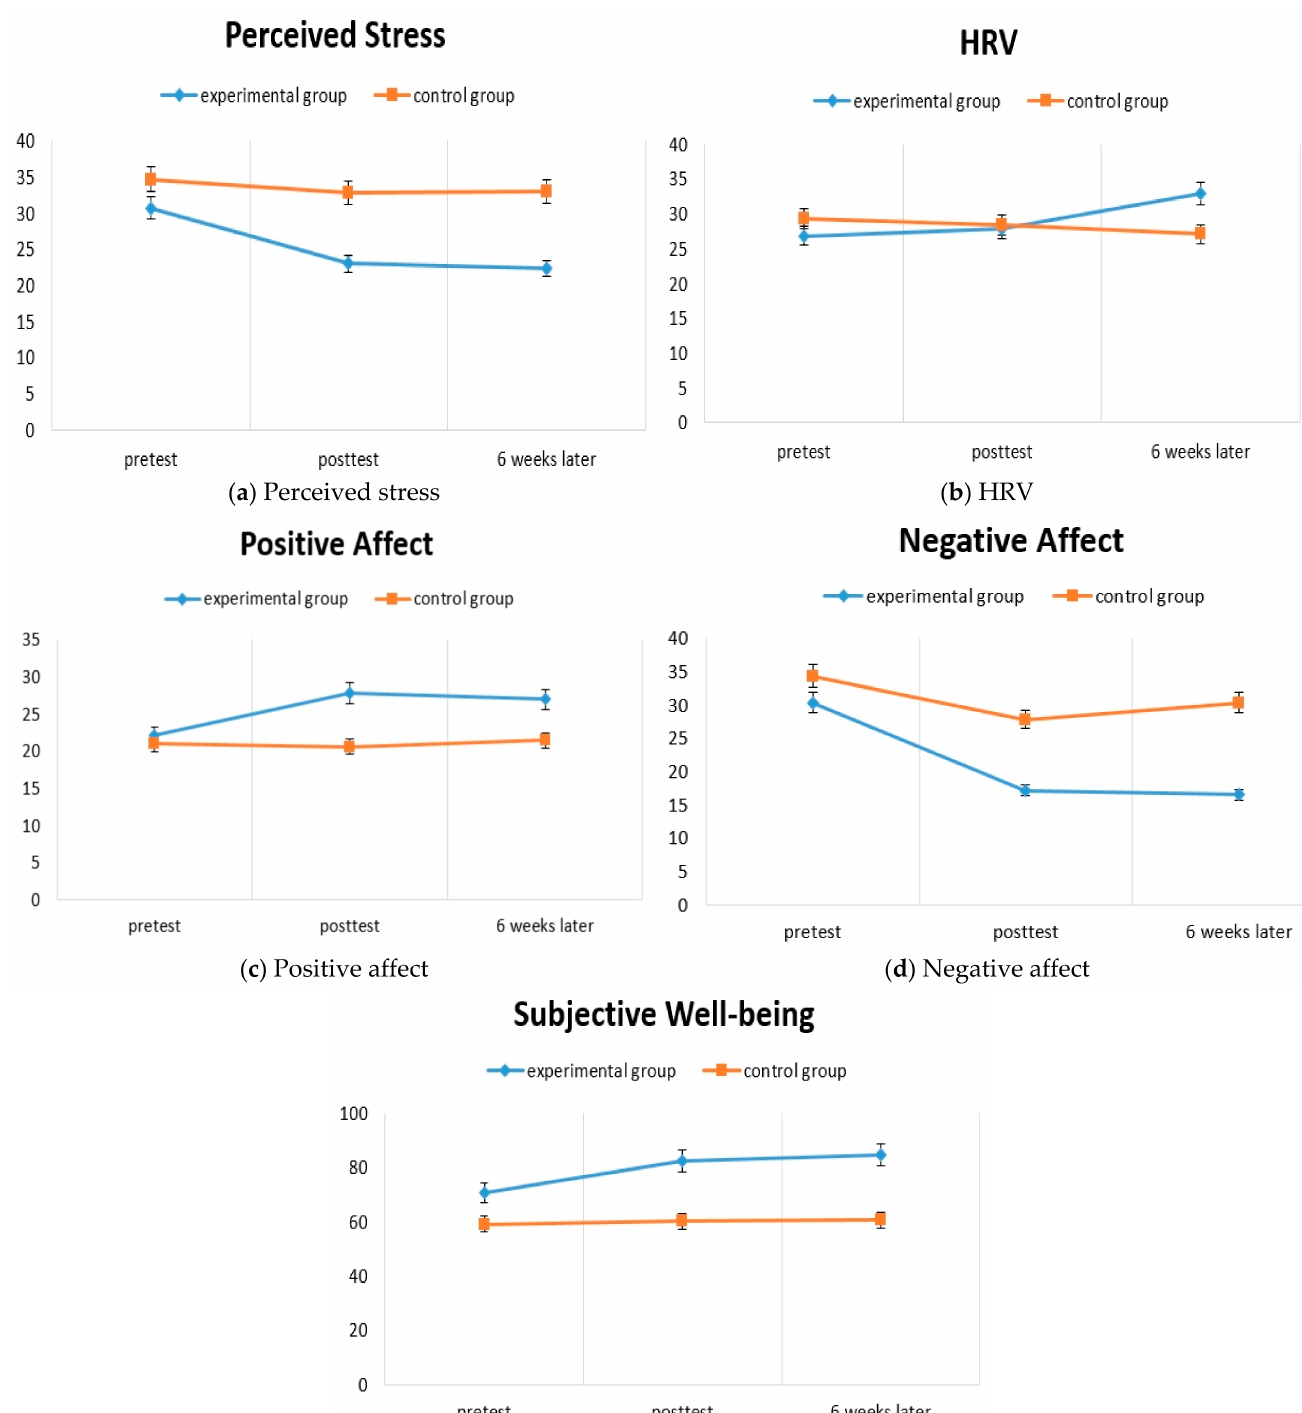
Figure 2. Hypothesis testing: ( a ) perceived stress; ( b ) HRV; ( c ) positive affect; ( d ) negative affect; ( e ) subjective wellbeing. Hypothesis 2 (“ Compared to the control group, the MBSR group will display a greater increase in heart rate variability ”): Analyses revealed a significant group × time interaction (F(1.57, 37.61) = 3.66, p = 0.042, η 2 = 0.241). Subsequent analyses showed a non-significant difference between groups at post-test (t(25) = 0.40, p = 0.691) and follow-up (t(25) = 2.00, p = 0.057), such that the MBSR group scored higher on HRV relative to the control group (Figure